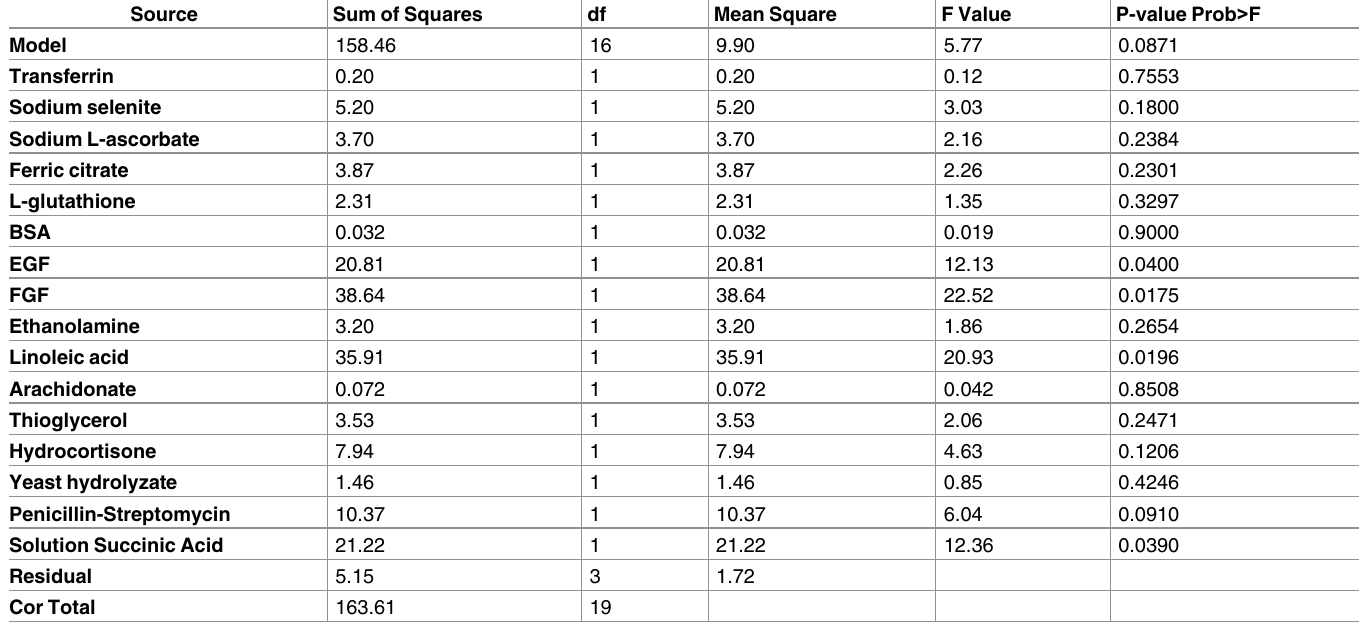
implying that the model equation could explain 96.71% of the total variation. Table 4. ANOVA for Plackett-Burman